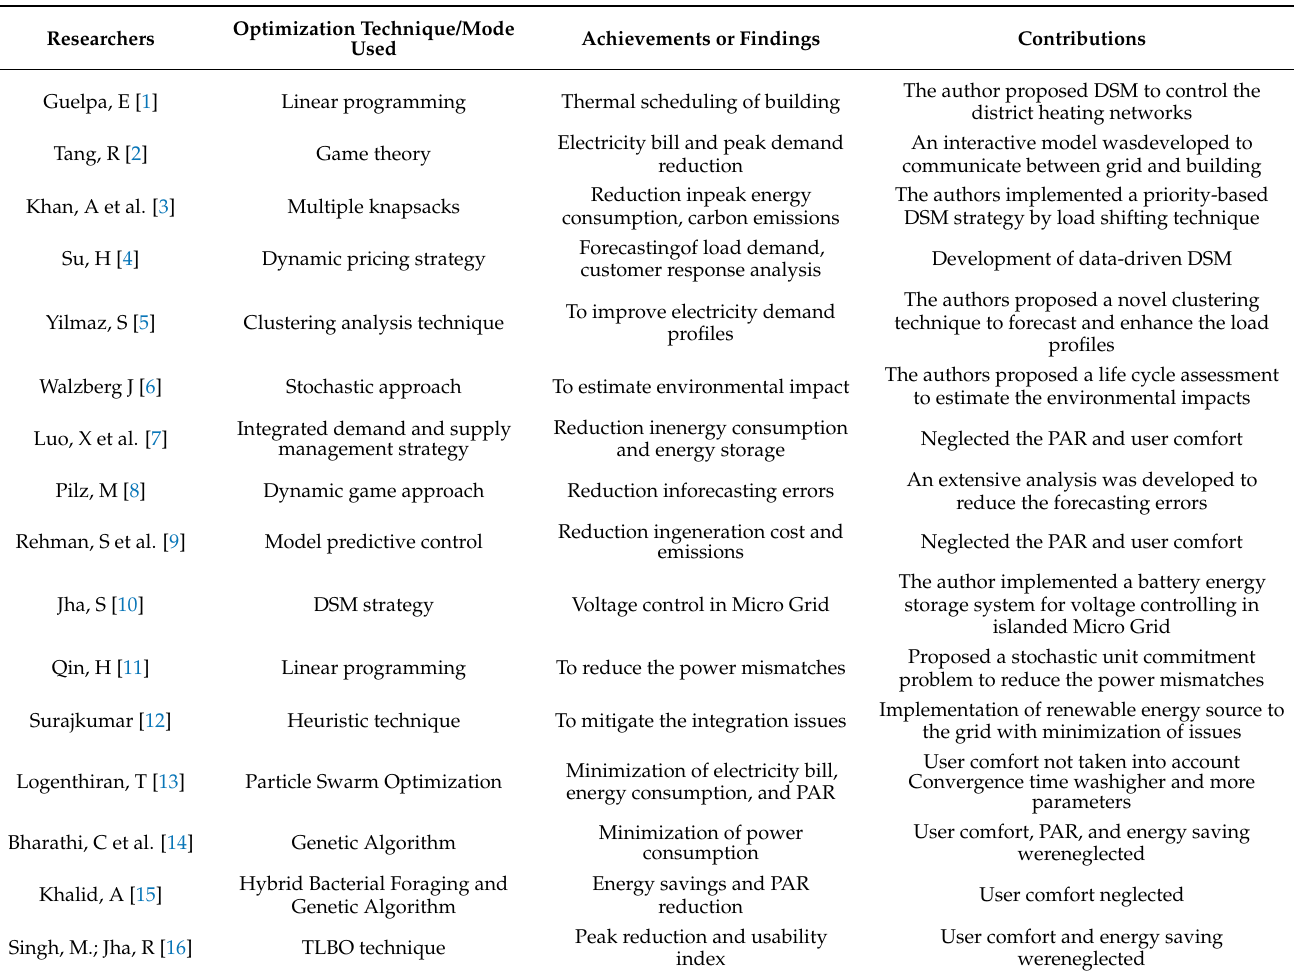
Table 1. Contributions from various